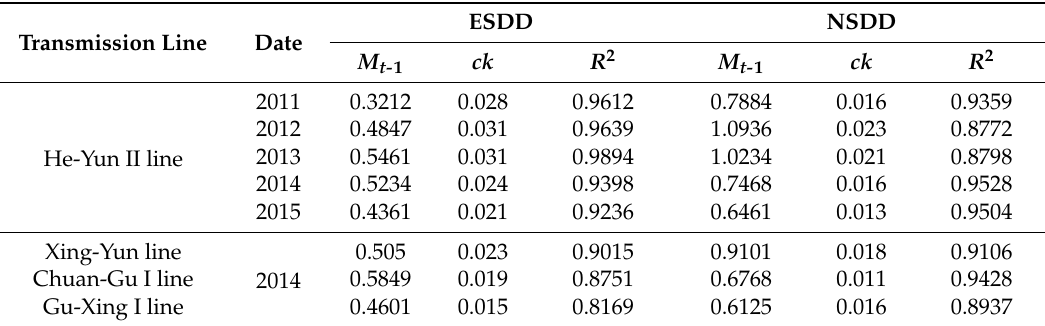
Table 4. Fitting results of the cleaning model of